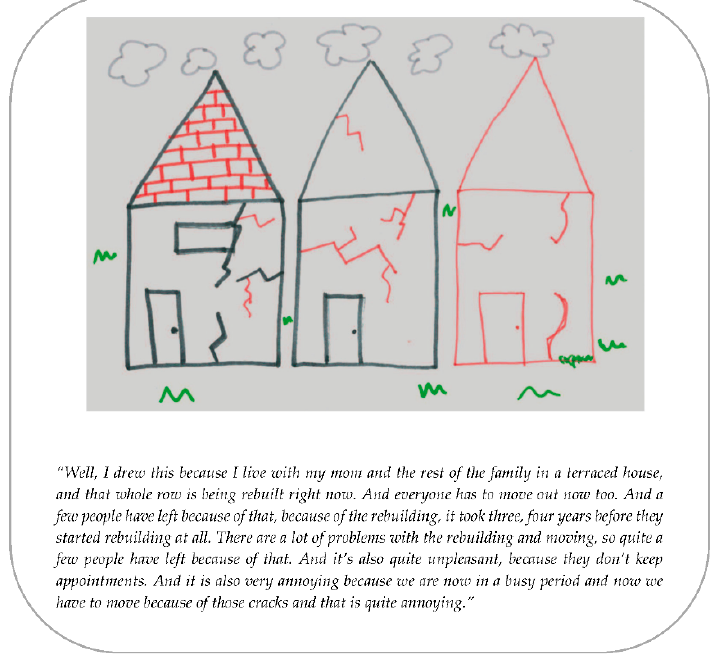
Figure 2. Drawing of a participant (14